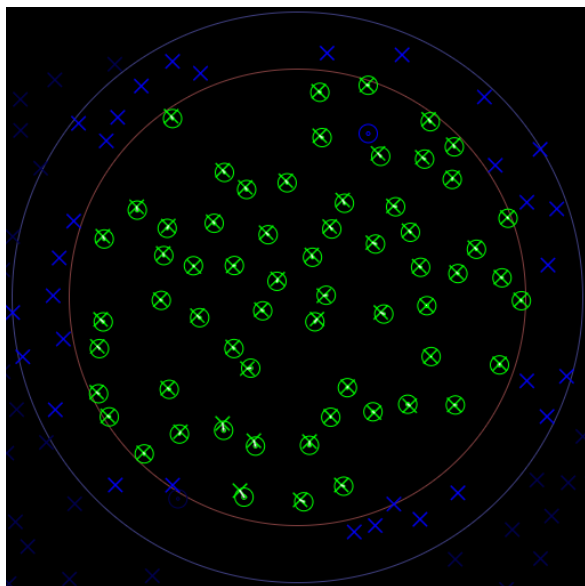
Figure 4. Automatic linking of laser and manual mesaured trees on a 20 m radius field plot (brown circle). The crosses are laser detected trees, the circles are manual measured trees, green symbols indicate linking.